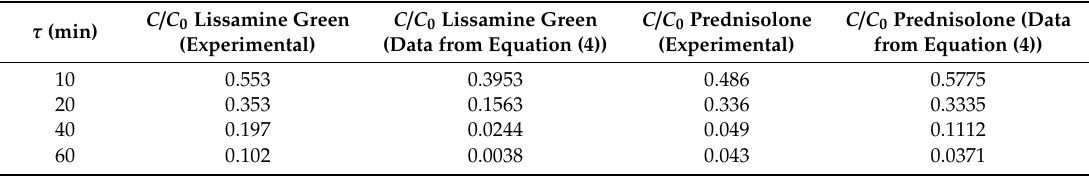
Table 2. Experimental and theoretical levels of lissamine green and prednisolone removal at di ff erent residence